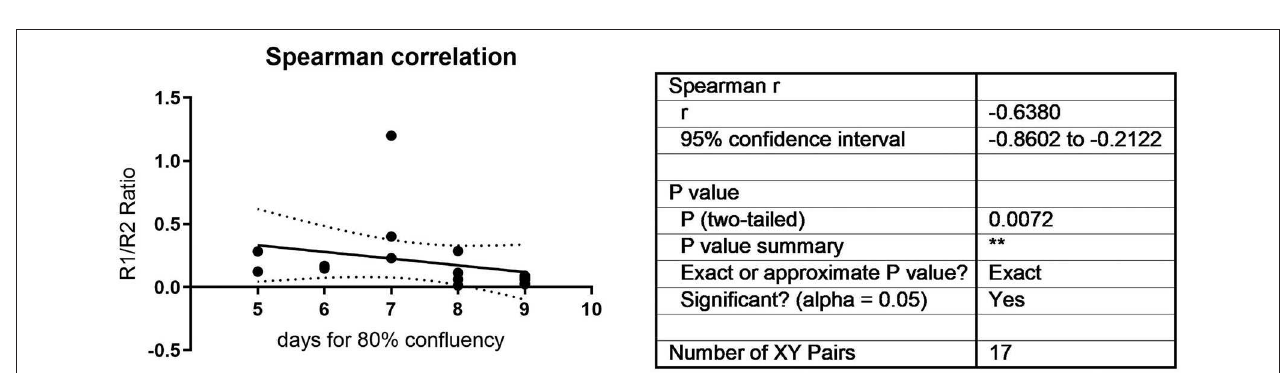
FIGURE 3 | Histological and molecular Spearman correlation between TGFBR1/ TGFBR2 ratio and histological scores.